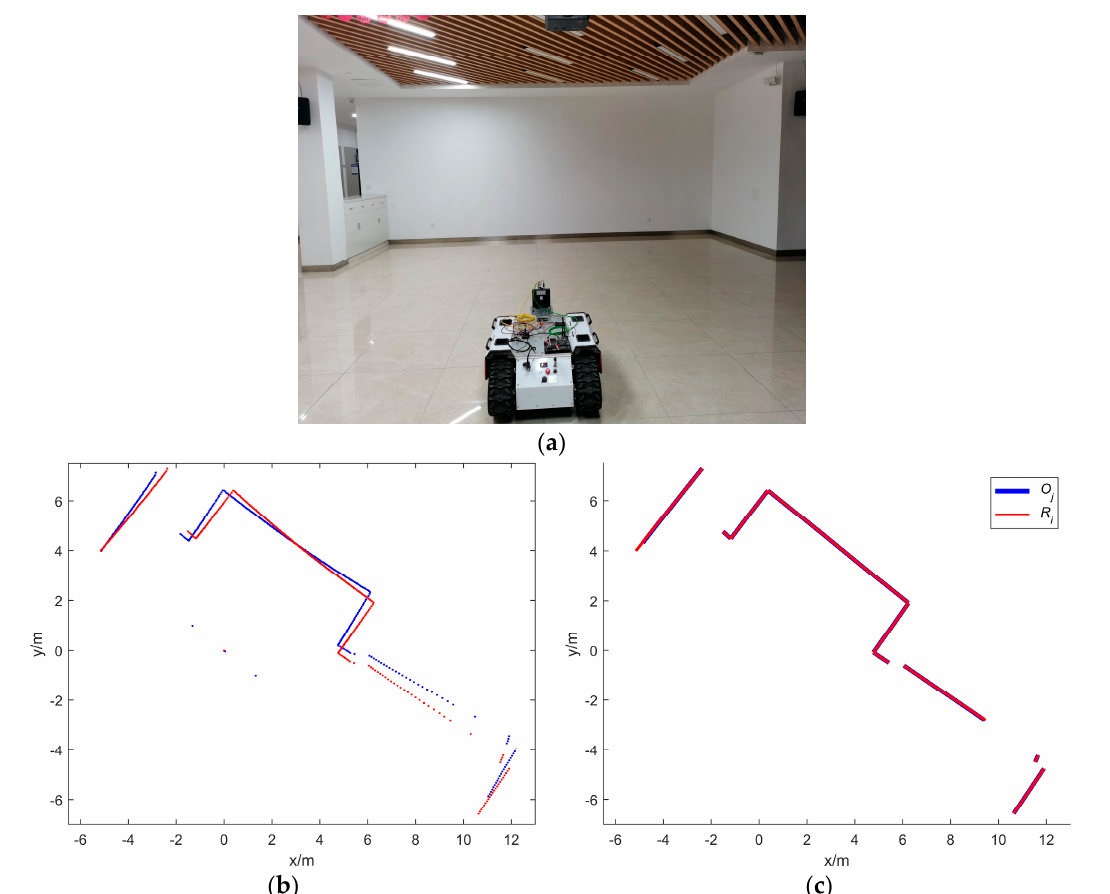
Figure 17. Simulation results of real-environment lidar data: ( a ) flat ground corridor environment; ( b ) two frames of laser point cloud; ( c ) point cloud line segment features after data registration.